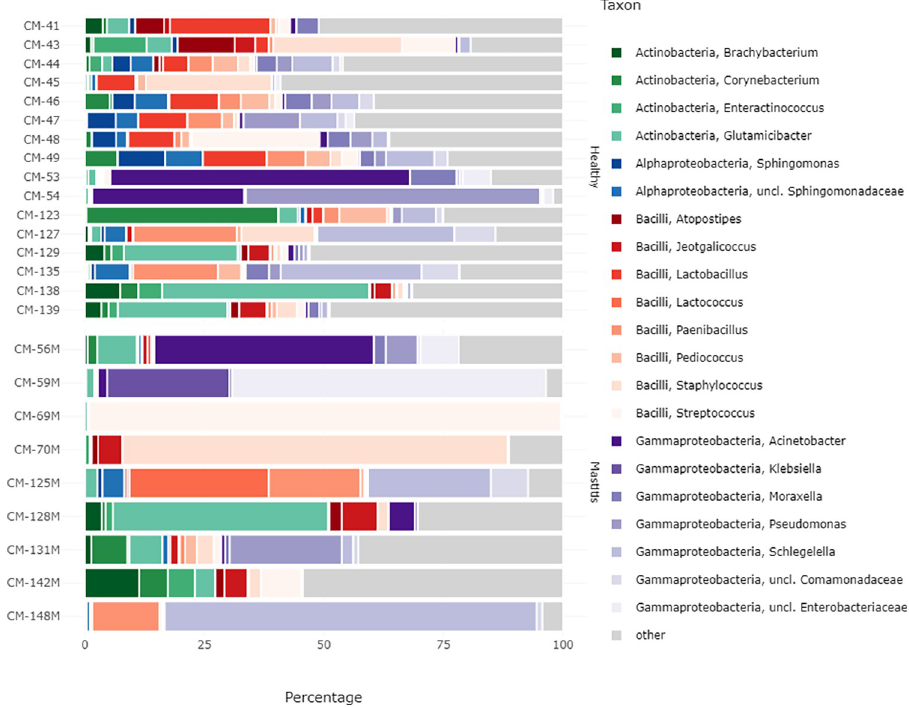
Fig 2. Taxon frequencies (percentage of total sample counts) of the most dominant bacterial population in healthy and mastitis camel milk summarized at the genus level for the 16S rRNA. Rare taxa with a mean abundance of < 1% across all samples are summarized as “Others”. M corresponds to the mastitis